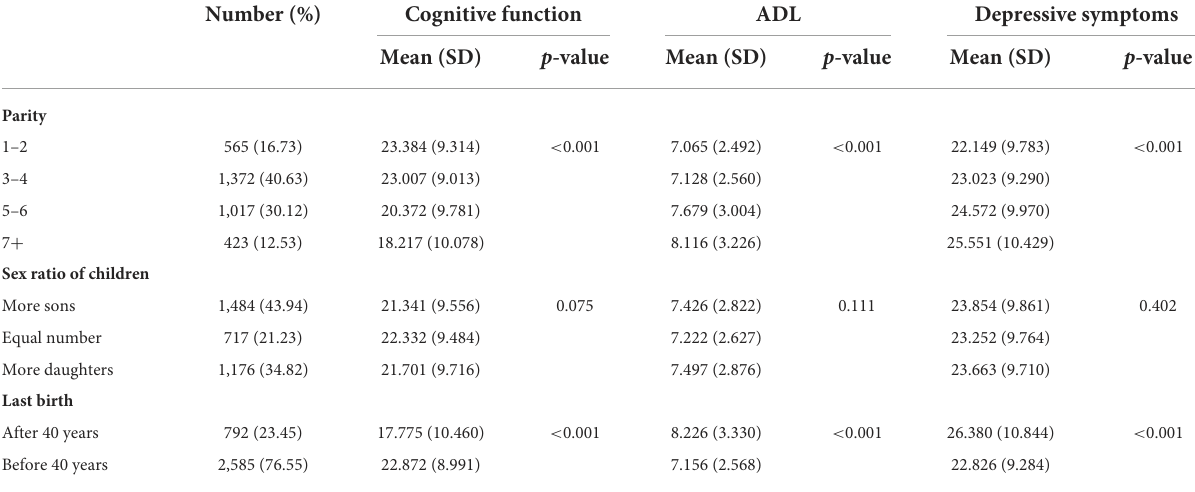
TABLE 2 Multidimensional health of older adults with different reproductive history ( N = 3,377). Number (%) Cognitive function ADL Depressive symptoms Mean (SD) p -value Mean (SD) p -value Mean